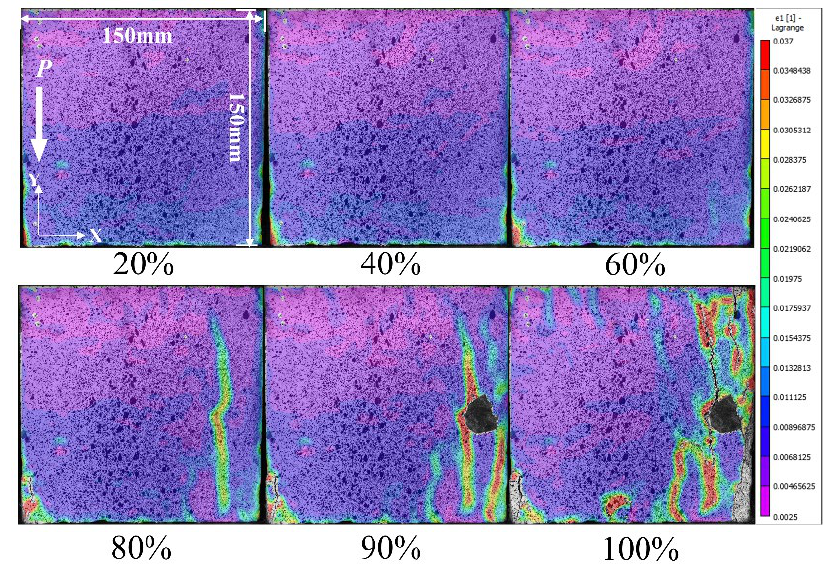
Figure 2. Principal strain distribution of D1 under different loading stages.